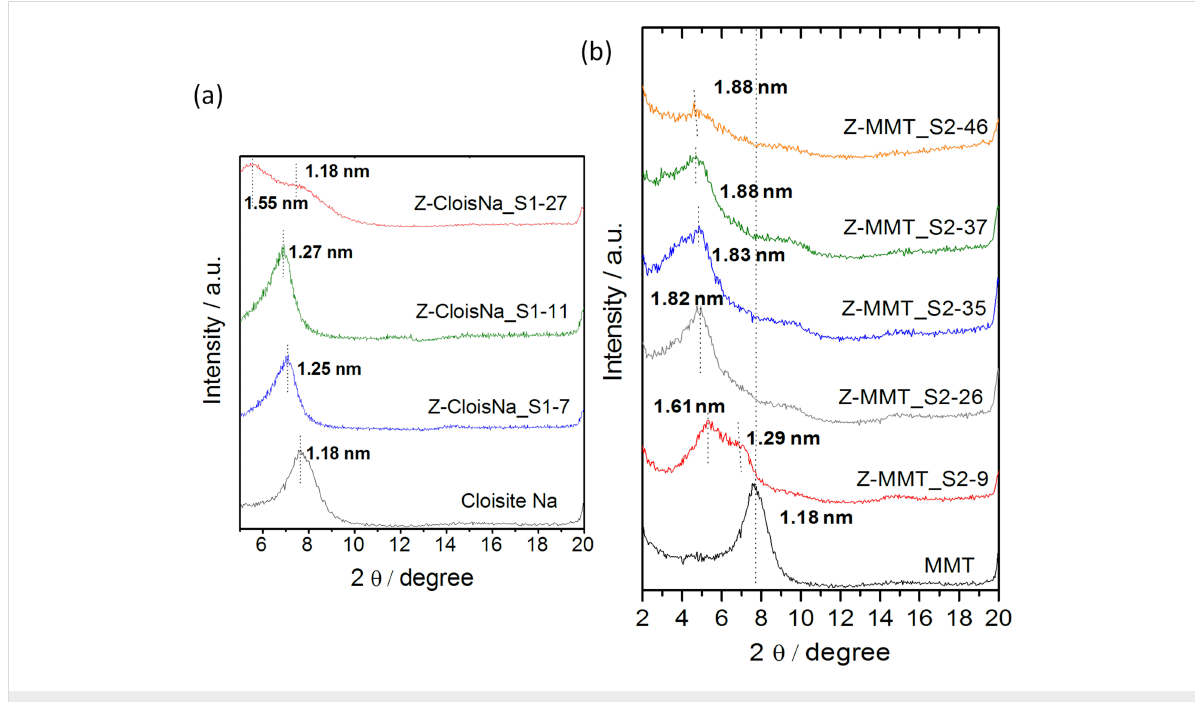
Figure 2: XRD patterns of (a) Z-MMT_S1 and (b) Z-MMT_S2 biohybrids.